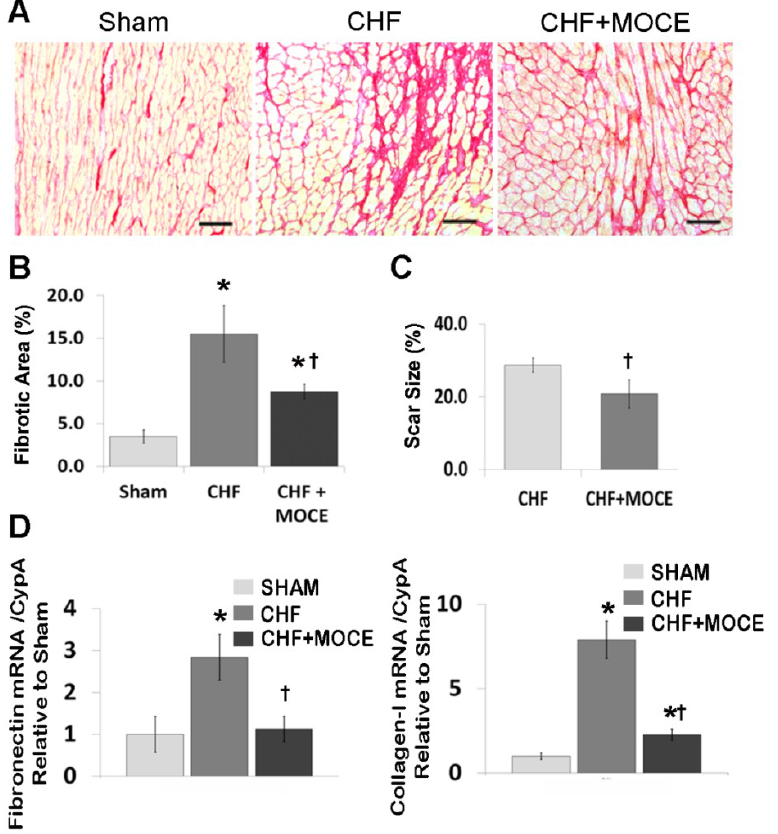
Figure 3. Mocetinostat reduced fibrosis and scar size. ( A ) Total collagen in heart sections were stained with Sirus Red in untreated and Mocetinostat-treated CHF animals. Representative images are shown. Scale bar, 50 µm; ( B ) Total collagen amount was quantified in Sirus red stained sections; ( C ) Scar size was measured in Trichrome-stained heart sections of untreated or Mocetinostat-treated CHF rats; ( D ) QPCR analysis was performed to measure mRNA levels of fibronectin and collagen-I in LV of sham, untreated and Mocetinostat treated CHF animals. Error bars indicate SE. MOCE, Mocetinostat; CHF, congestive heart failure; * , p < 0.05 compared to shams; †, p < 0.05 compared to untreated